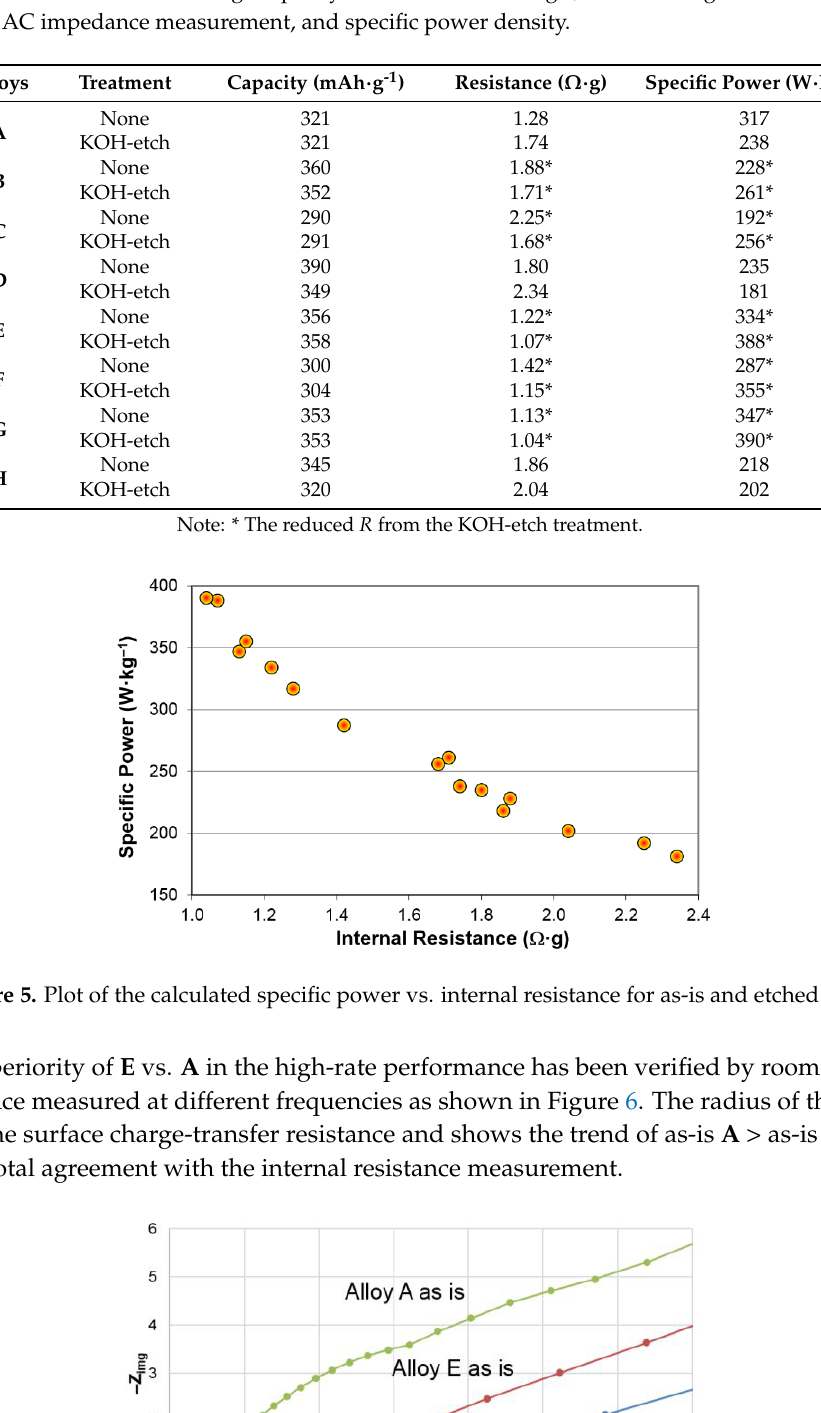
Table 2. Electrochemical discharge capacity measured at 50 mA · g -1 , surface charge-transfer resistance ( R ) from AC impedance measurement, and specific power density.